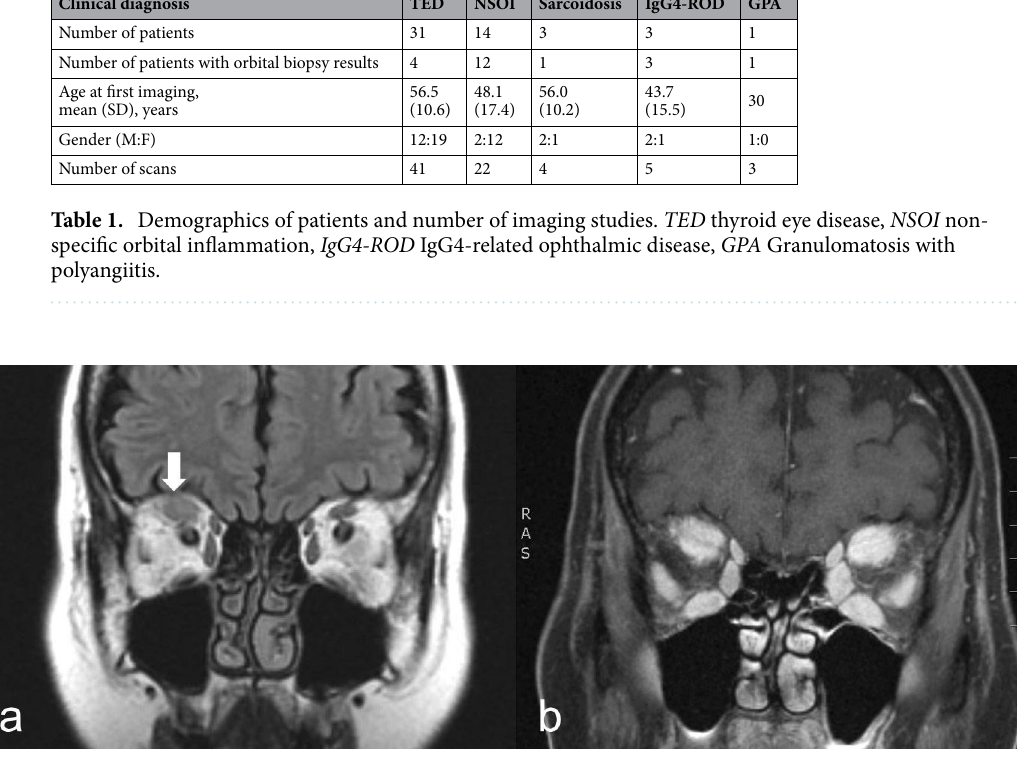
Figure 1. Two consecutive magnetic resonance (MR) scans of 1 patient with thyroid eye disease. ( A ) FLAIR MR image at initial visit shows enlarged superior rectus in the right orbit with slightly increased signal (white arrow). ( B ) After 8 months, fat suppressed T1-WI contrast enhanced MR of the same patient demonstrates mildly asymmetric enlargement of all extraocular muscles in both orbits with intense associated enhancement. The radiologic diagnosis for these 2 scans was non-specific orbital